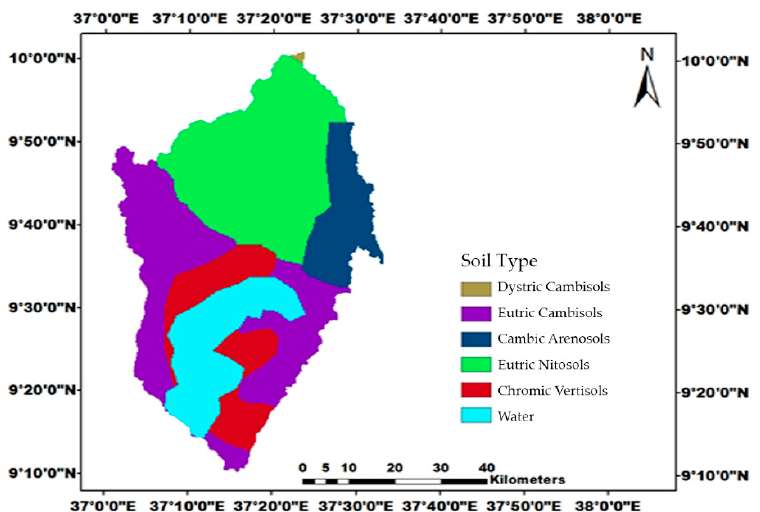
Figure 7. Soil map of the Fincha’a watershed.